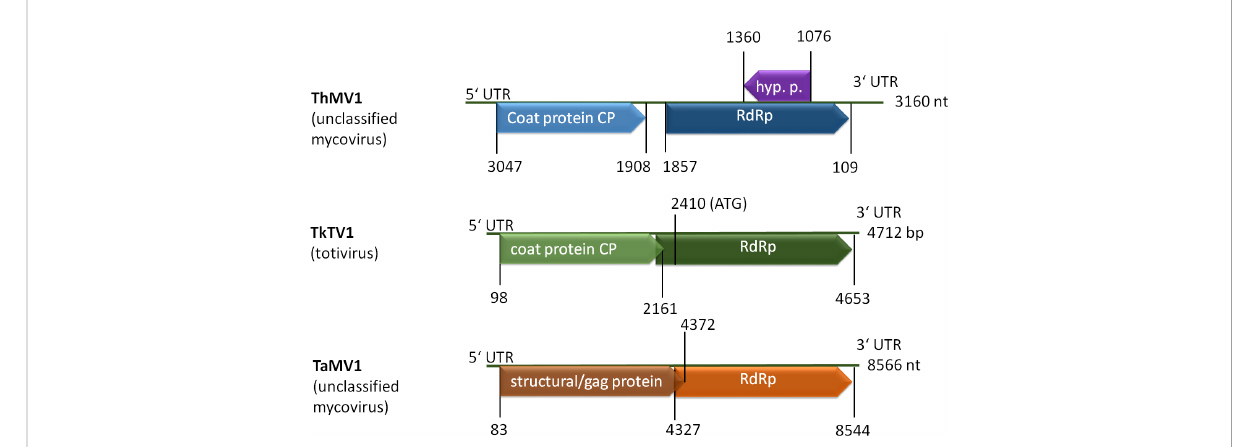
FIGURE 4 Schematic representation of selected mycovirus genomes. ThMV1 (Liu et al., 2019), TkTV1 (Khalifa and MacDiarmid, 2019) and TaMV1 (Lee et al., 2017) genomes comprise two ORFs coding for a coat protein (CP or GAG) and an RNA dependent RNA polymerase (RdRp). ThMV1 additionally comprises a small ORF encoding a hypothetical protein of unknown function.